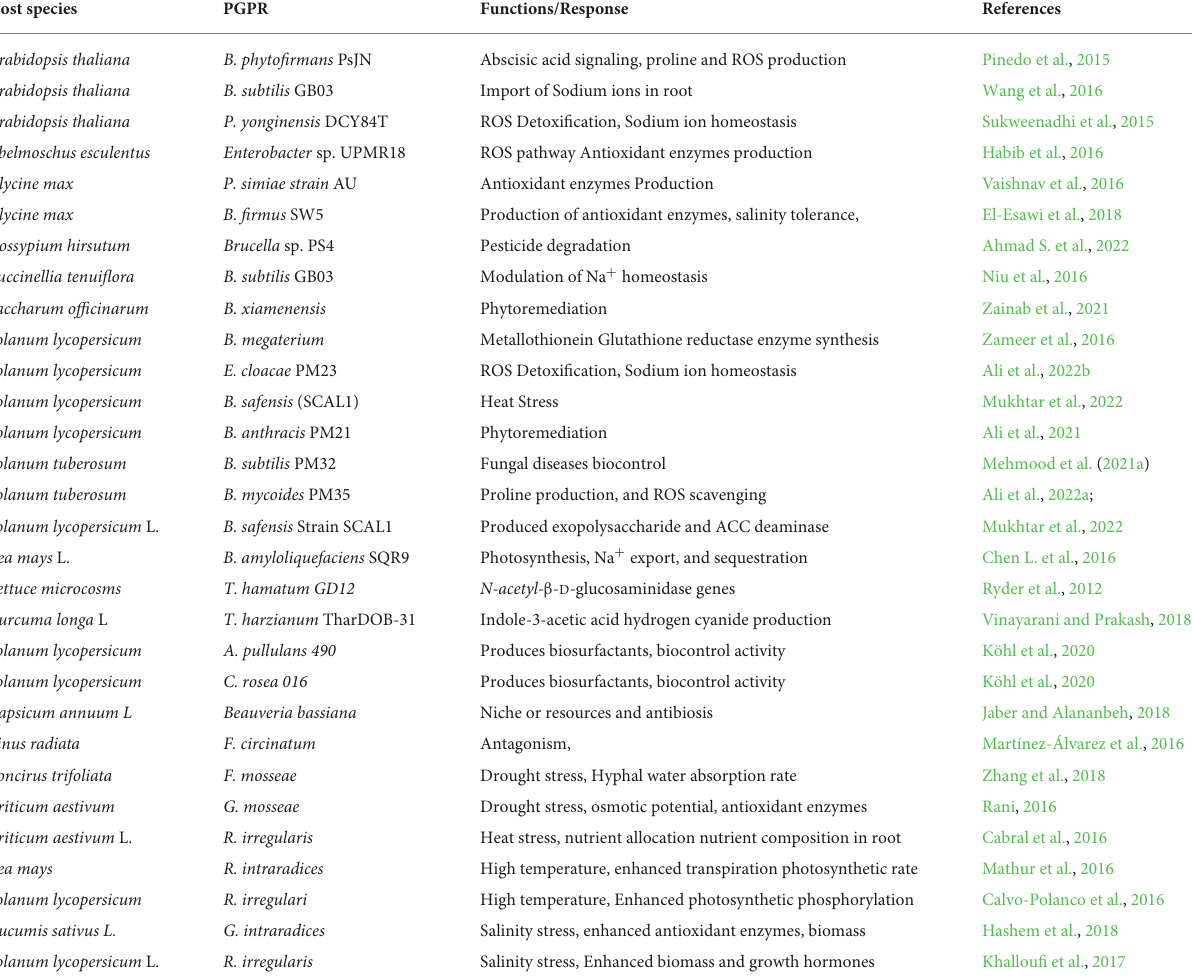
TABLE 1 Plant growth promoting microbes underpinning plant growth and enhance tolerance against biotic and abiotic stresses employing various